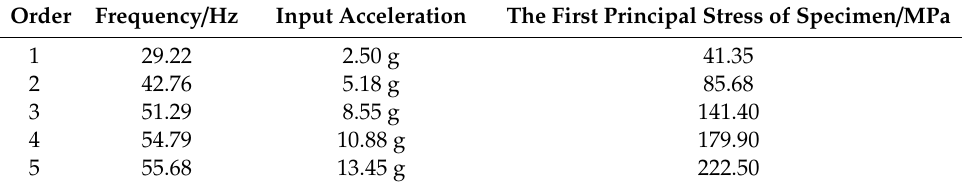
Table 4. Simulation results of structural mode and static strength.